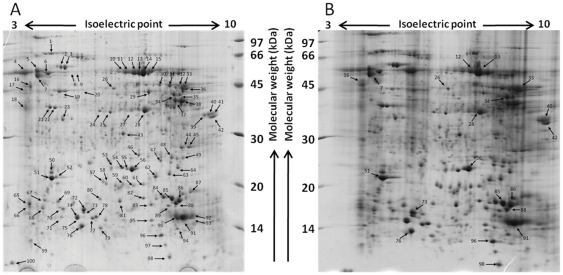
Colloidal Coomassie blue-stained 2-DE gel images of H. contortus cytosolic proteome.250 µg (A) or 500 µg (B) H. contortus cytosolic proteins were fractionated on pH 3–10 non-linear immobilised pH gradient strips and then run on a 12.5% polyacrylamide gel for the second dimension. (A) 100 spots showing the highest normalised volumes (area×intensity) were analysed using MALDI-TOF MS with PMF searching of databases. (B) 20 spots, matched to the previous gel image (A), were analysed using Q-TOF MS/MS with Ion Searches of the putative EST H. contortus protein database and the identified sequences used for BLASTp searches of the NCBI protein database.